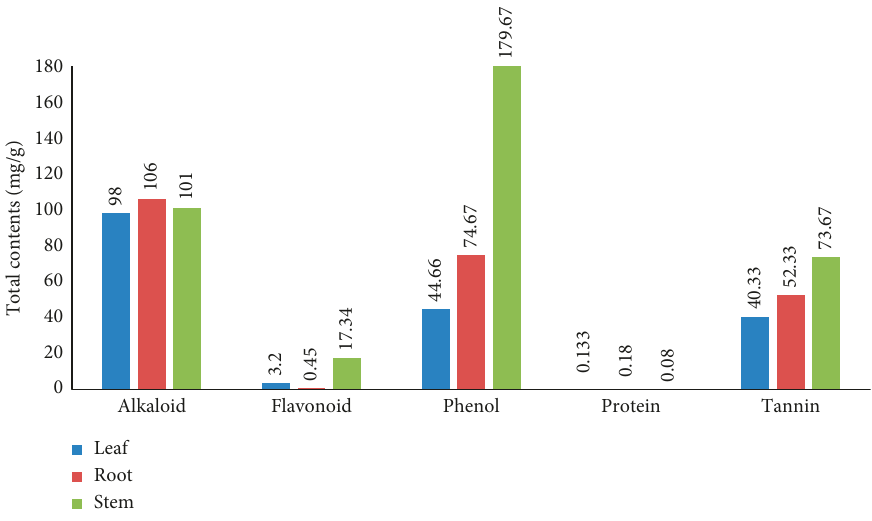
Figure 1: Quantitative phytochemical analysis of C. lanatum .